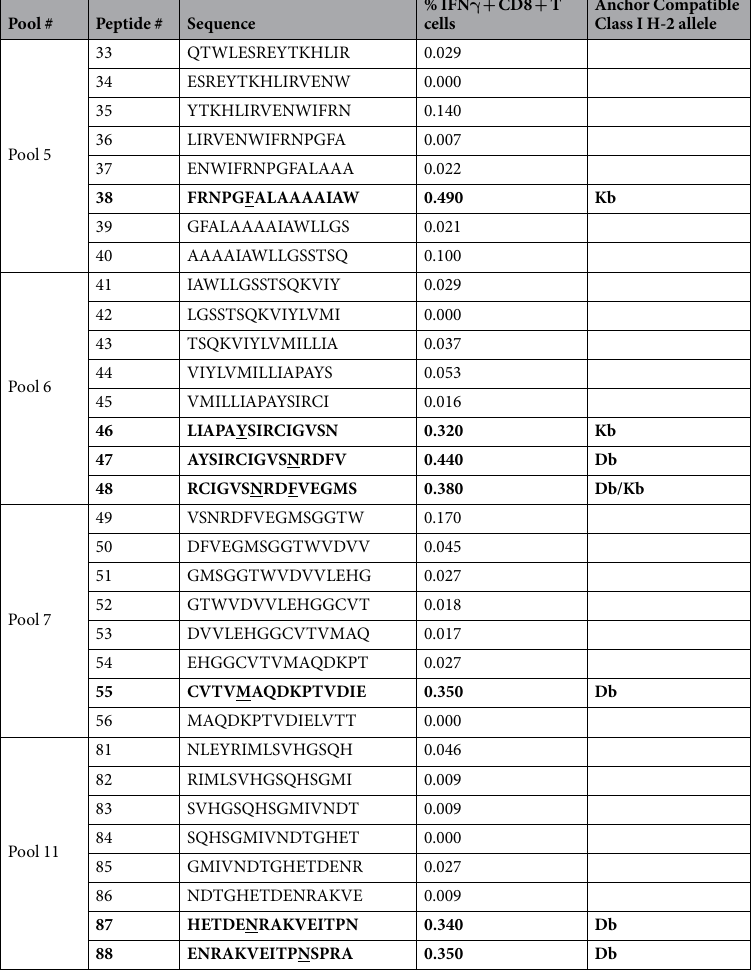
Table 1. 15-mer Peptide candidates tested individually for CD8 + T cell cytokine release. Peptides that induced IFN γ expression in > 0.2% of CD8 + T cells were considered hits. Possible anchoring residues are